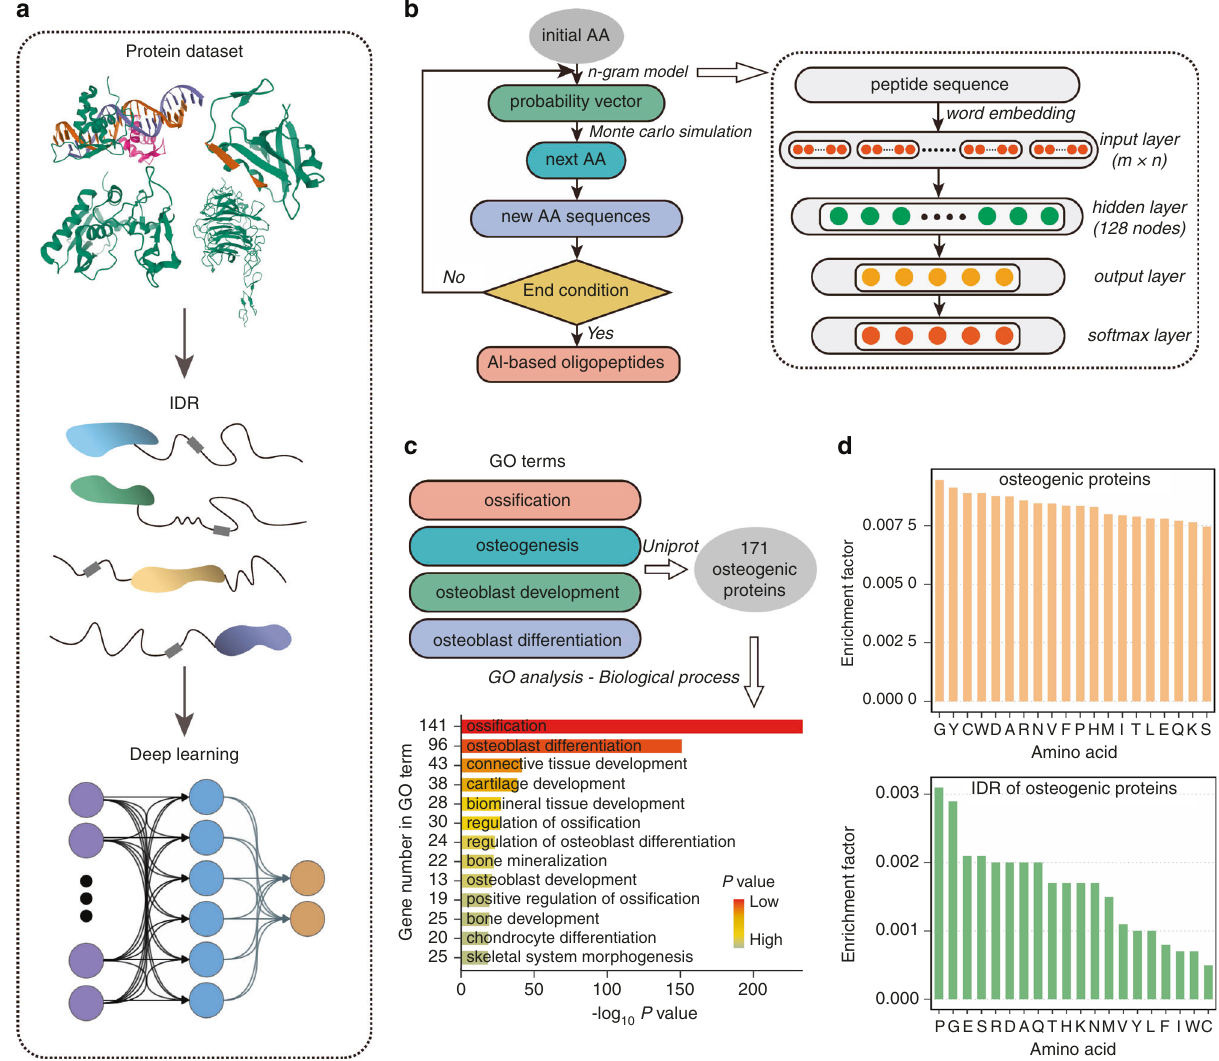
Fig. 1 Design for a functional oligopeptide screening strategy using deep learning. a Work fl ow of the oligopeptide screening procedure. Brie fl y, the intrinsically disordered regions (IDRs) of proteins were employed to build a functional peptide motif dataset. b Architecture of the deep learning-based oligopeptide generation model: the model comprises two submodels, namely, N-grams and Monte Carlo simulation. The ten amino acids (AAs) with the highest frequency are used as the “ initial AAs ” . N-grams are used to infer the conditional probability of the context words (residues) of the oligopeptides awaiting extension, and the Monte Carlo simulation then generates the extended oligopeptides according to inferred probabilities. The overall model represents a repeating cycle of this basic process, with one AA extended in each cycle. The new oligopeptides obtained in each cycle then serve as oligopeptides awaiting extension in the next cycle until the end condition of the cycle is reached (here, until the oligopeptides have been extended to a total of 10 residues). c Protein candidates were retrieved from UniProt based on their reported involvement in bone formation by using four osteogenic GO terms: “ ossi fi cation ” , “ osteogenesis ” , “ osteoblast development ” , and “ osteoblast differentiation ” . A total of 171 protein candidates were thus collected. d Display of amino acid frequency distribution in the intrinsically disordered regions or full-length sequences of 171 ossi fi cation-annotated (Fig. S5D). Intravenous injection of AIB5P had no signi fi cant effect on the body weight of mice. Taken together, these results demonstrate that AIB5P is an effective osteogenic oligopeptide that does not cause any obvious side effects.